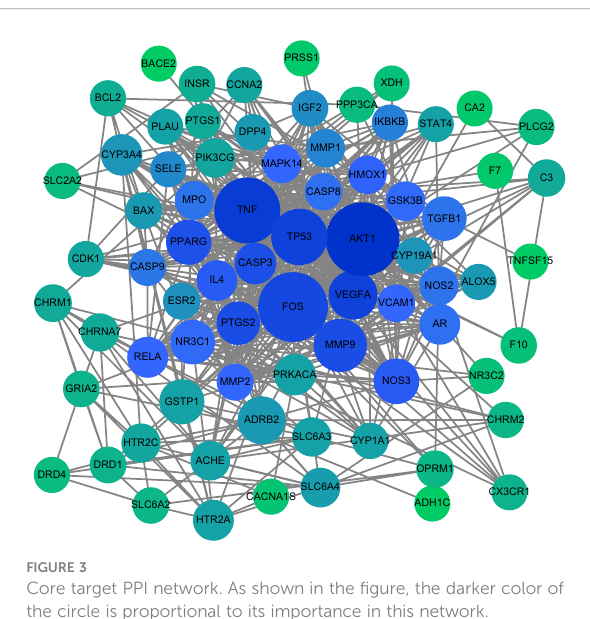
FIGURE 2 Disease-drug target Venn diagram.